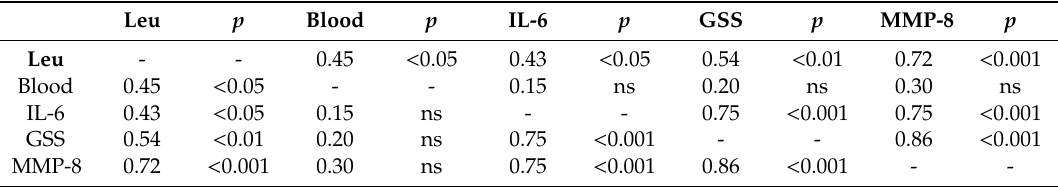
Table 2. Coe ffi cient of Correlation by Pearson’s between Salivary Biomarkers and Para-clinical Indicators from Urine